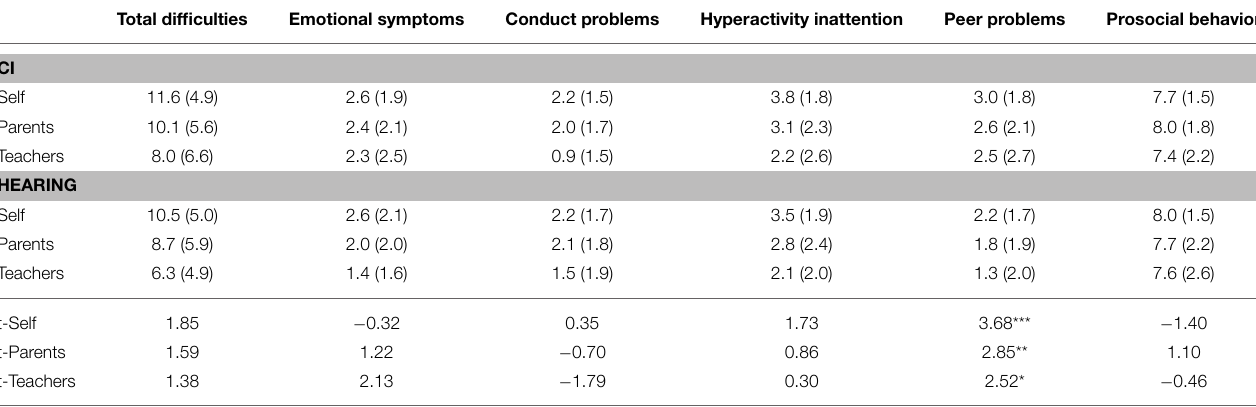
TABLE 5 | Scale means (SD) and T -values for comparison of SDQ mean scores between CI group ( n = 129 self, n = 139 parents and n = 55 teachers) and NH group ( n = 140 self, n = 70 parents and n = 42 teachers), matched by age, gender and social background. Total